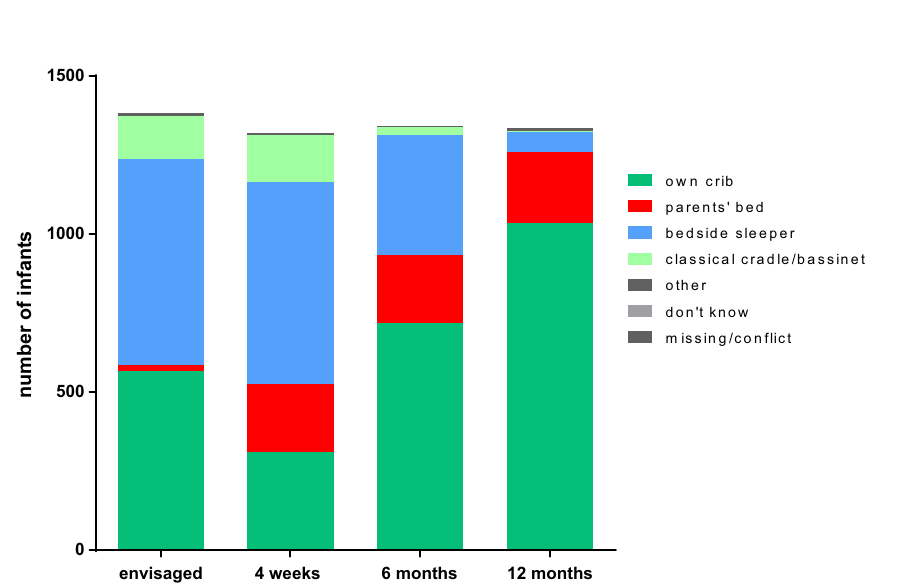
Figure 1. Default sleep location (“ In which room does your child usually sleep at night? ”).